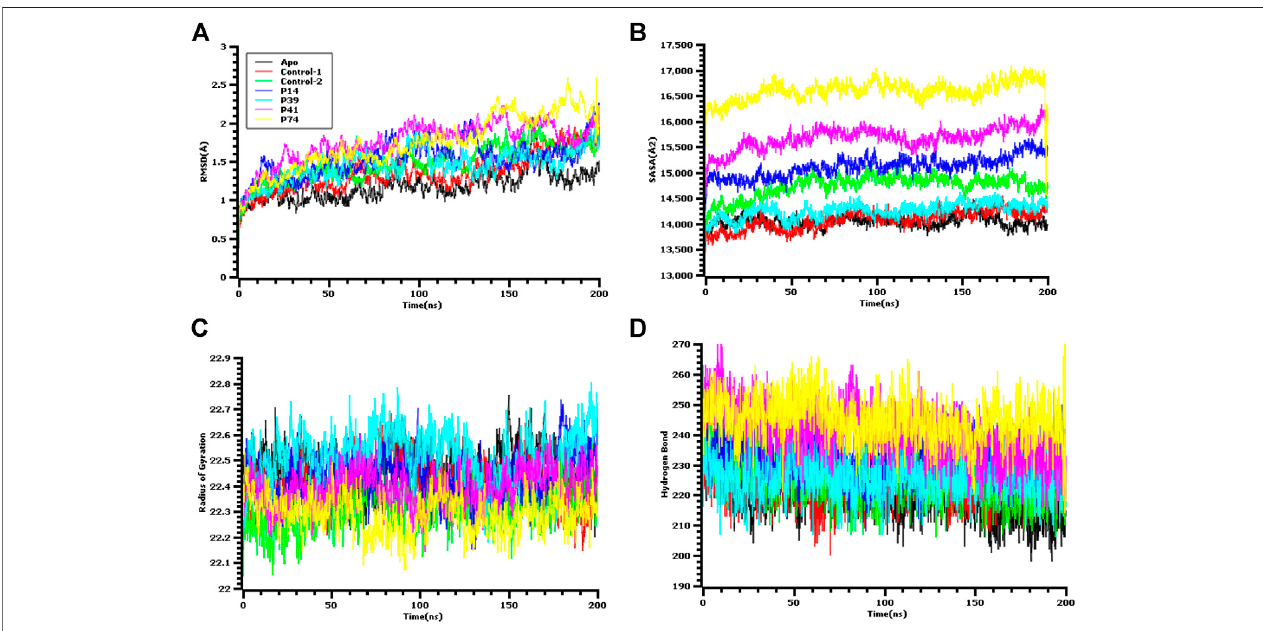
FIGURE 5 | Molecular dynamics simulation study of the peptide and main protease enzyme. (A) Root mean square deviation of the C-alpha atom, (B) the solvent accessiblesurfaceareaoftheproteinvolumetounderstandthechangeinproteinvolume, (C) theradiusofgyration,and (D) thehydrogenbondoftheproteincomplexto evaluate their stability in